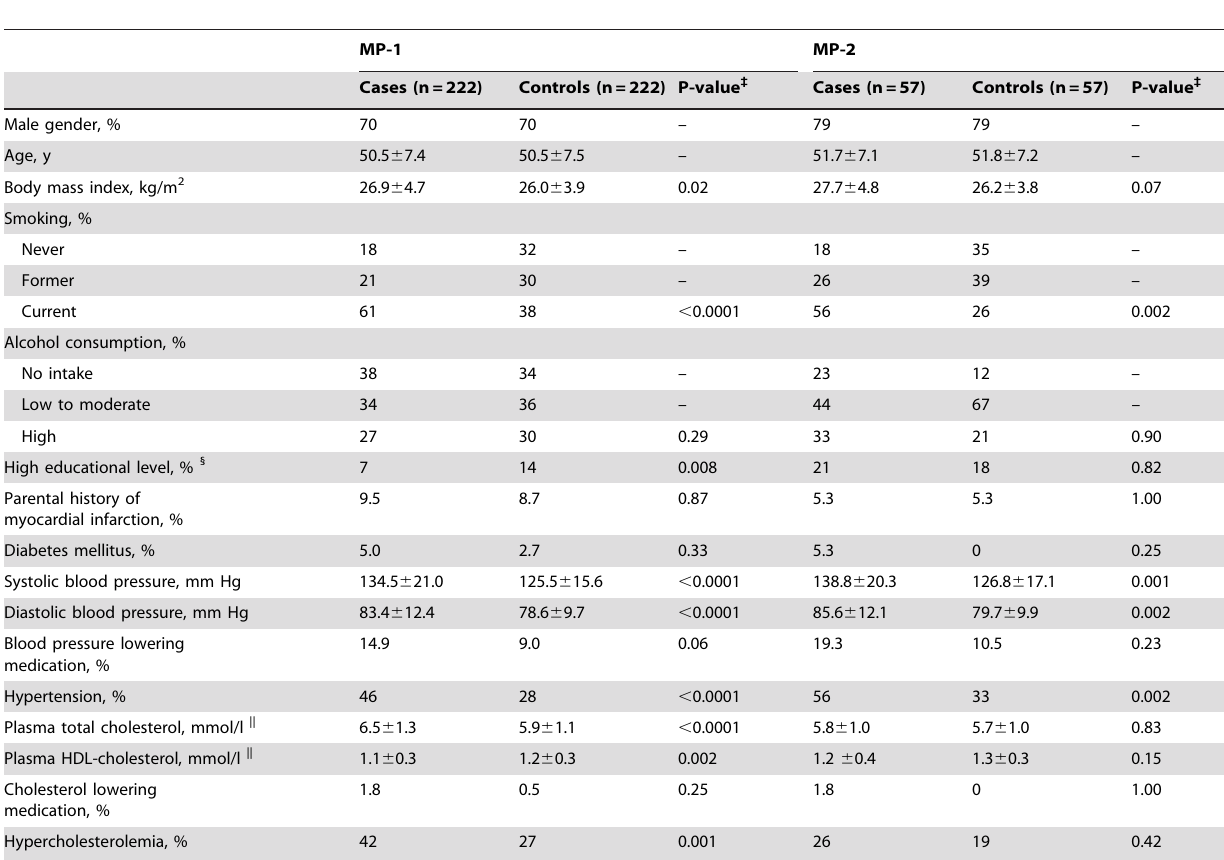
Table 1. Baseline characteristics of 279 fatal coronary heart disease cases and 279 matched controls. *,